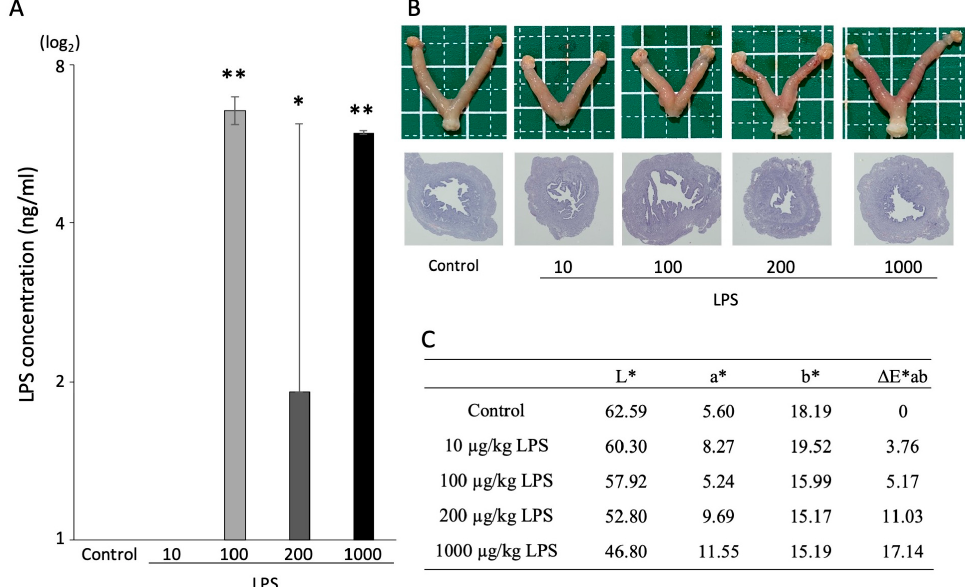
Figure 1. Effect of LPS on the immune response in the uterus. ( A ) Concentration of LPS in the plasma (n = 3). The values are shown as mean ± SEM. * p < 0.05, ** p < 0.01. ( B ) Histological examination of uteruses after administration of LPS. ( C ) Measurement of uterus color using spectrophotometry. L*: lightness, a*: redness, b*: yellowness.